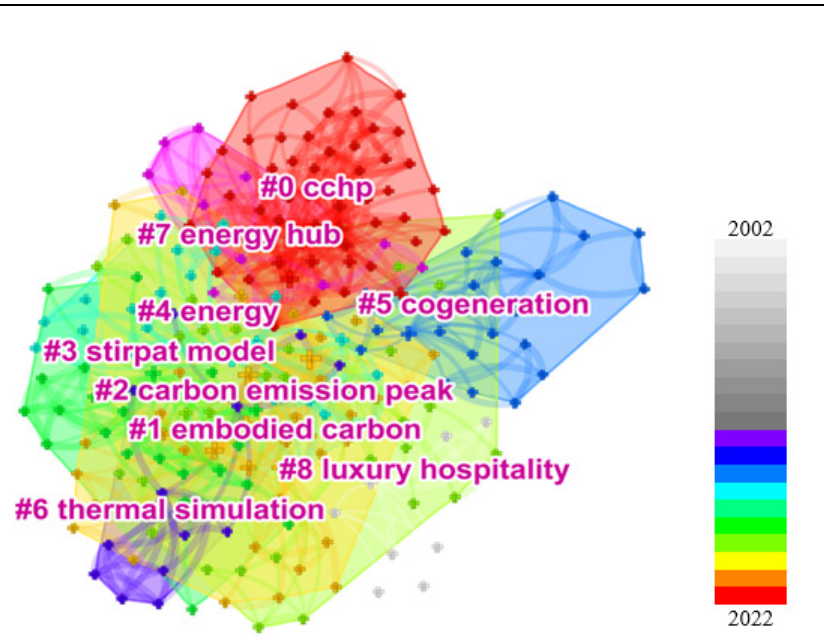
Figure 4. Keyword clustering diagram for the research of CEPB.